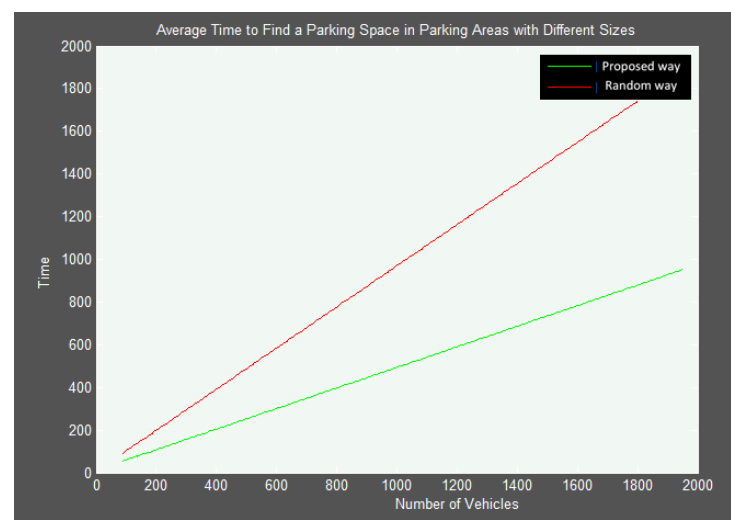
Figure 11. Average time to find an available parking space.